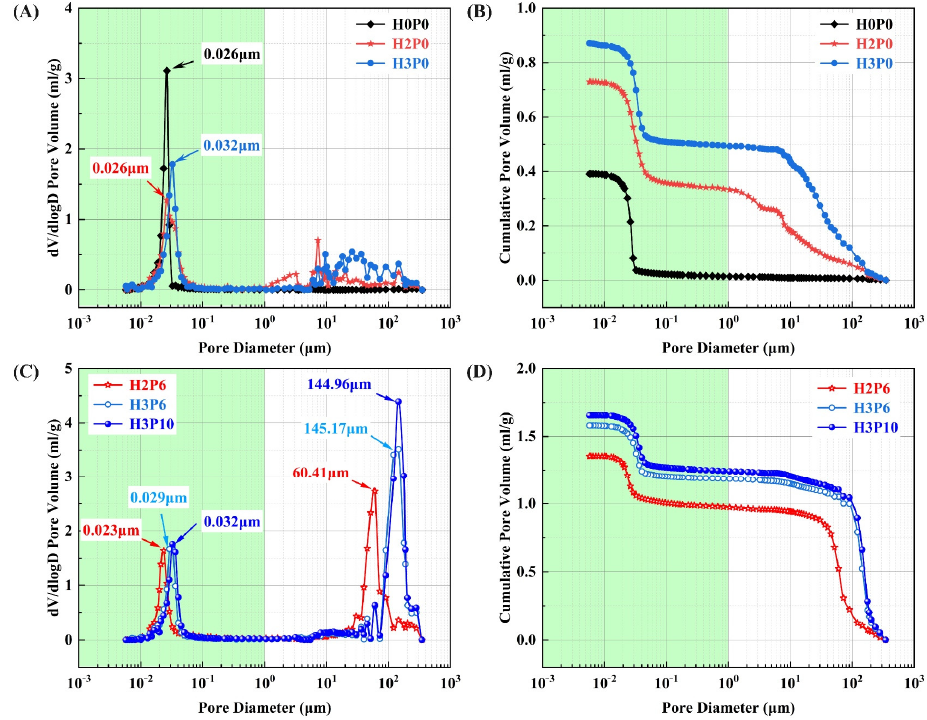
Figure 8. Pore size distribution of matrix and geopolymer foams: ( A , B ) H0P0, H2P0, and H3P0; ( C , D ) H2P6, H3P6, and H3P10.